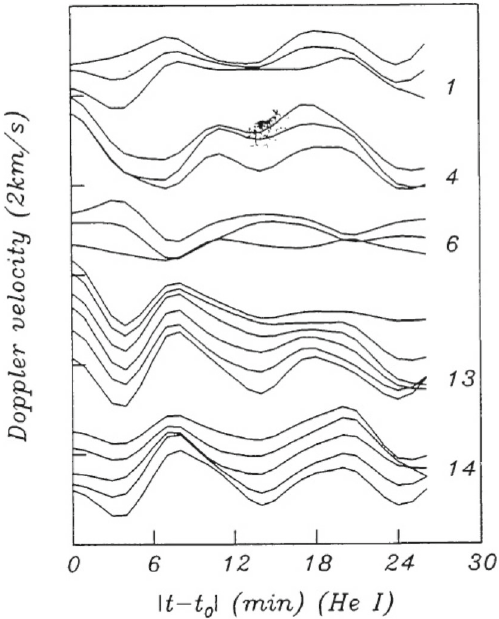
Fig. 13 Temporal variation of the Doppler velocity along threads of a solar filament. Numbers on the right label the various threads. For each thread, the curves correspond to the Doppler velocity measured at different points along the